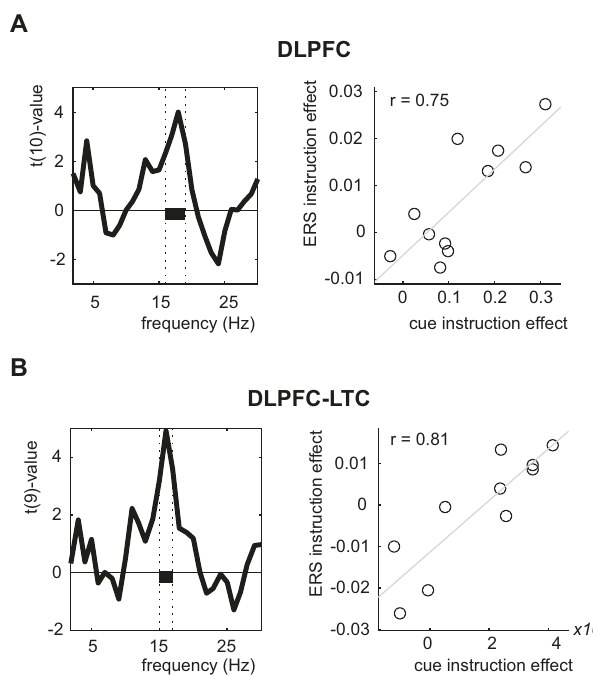
Fig. 8 Inter-individual correlations across participants between the cue instruction effects and the encoding-retrieval similarity instruction effect. A Correlation between dorsolateral prefrontal cortex (DLPFC) power ( n = 11) and B DLPFC — lateral temporal cortex (LTC) coherence ( n = 10). Correlations are estimated at the time/frequency ranges of the cue effects (see Fig. 7). The black bar indicates signi fi cance at the p = 0.05 levels. Scatterplots indicate the effect at the peak of the signi fi cant power/ coherence effect. Circles indicate individual participants. Inset indicates the Spearman correlation value. Source data are provided as a Source Data fi